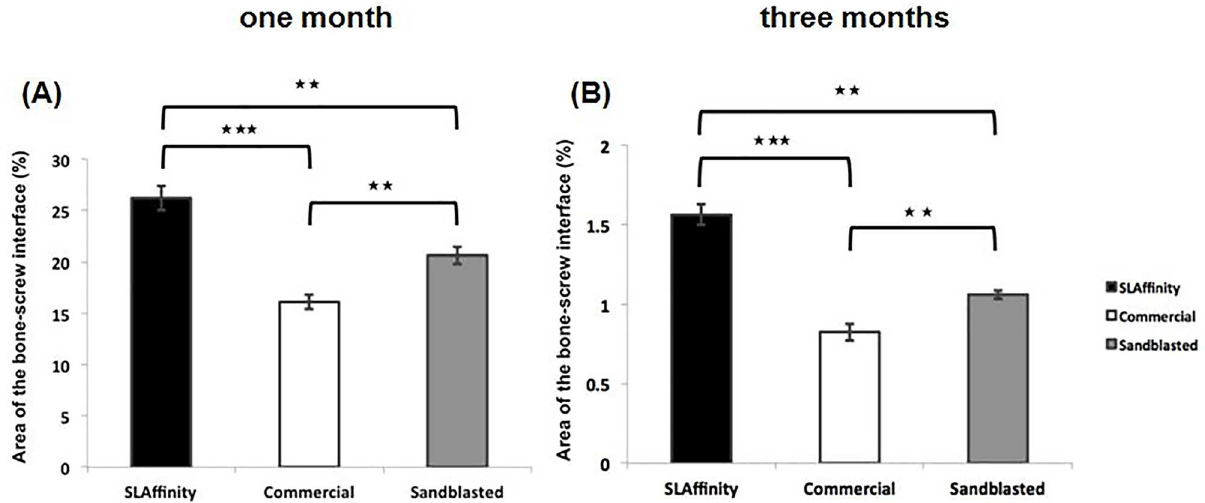
Fig 5. Quantitation of micro-CT images of different pedicle screwsinserted into vertebral column after implantation. (A) 1 month and (B) 3 months after implantation. * : p < 0.05, ** : p < 0.01, and *** : p < 0.001.